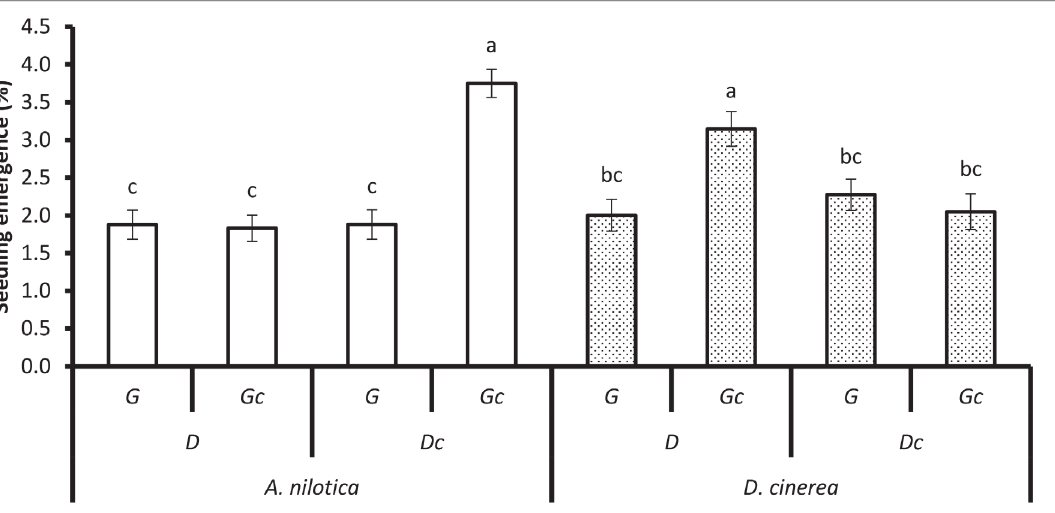
Fig 6. The treatment combination effects of seed species ( A . nilotica , D . cinerea ), dung (D) (and no dung (Dc)), grass (G) (and mowed grass (Gc)) on seedling emergence during the wet season. Bars represent standard errors (S.E). Same letters on the bars mean that P > 0.05. A LSD post hoc test was